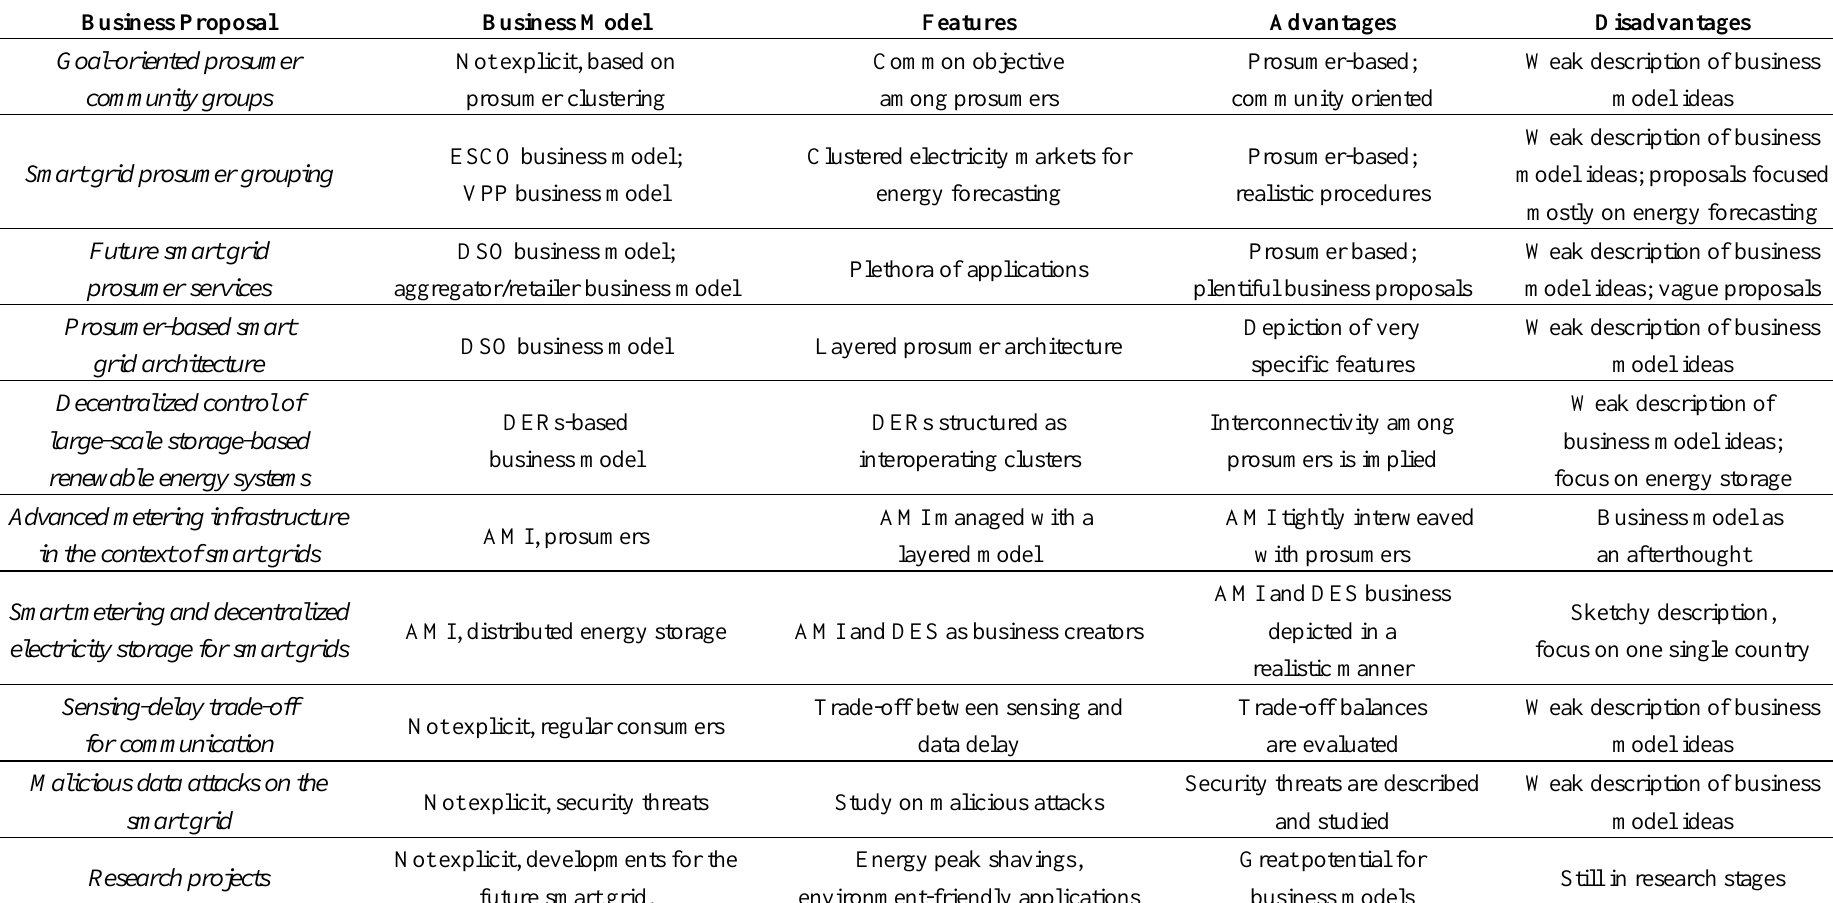
Table 3. Main features of prosumer business models and proposals. ESCO: energy services